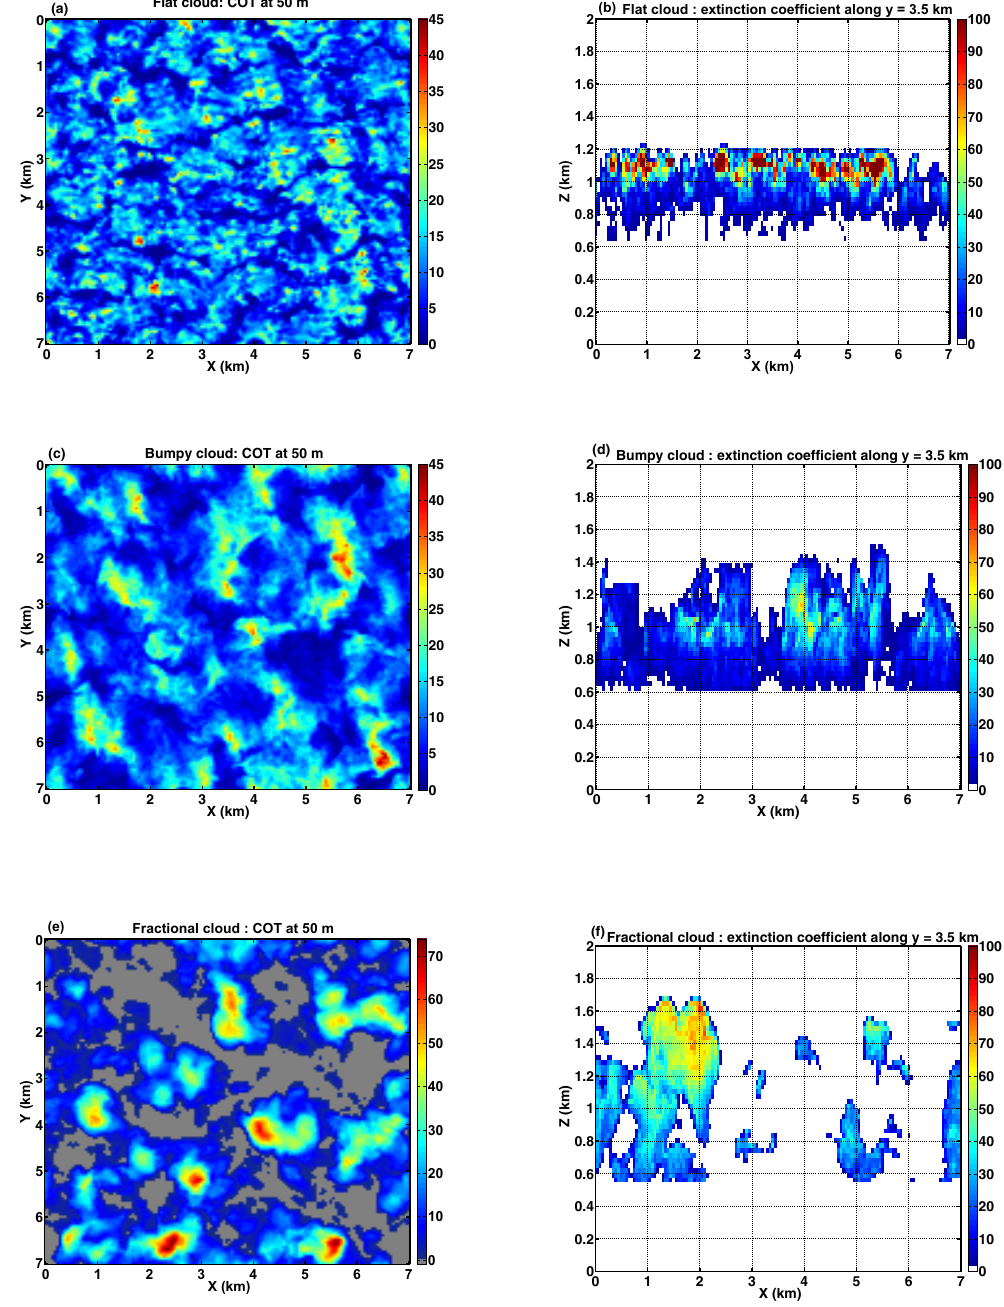
Figure 2. Cloud optical thickness (COT) of the three clouds used for the study (a) the flat cloud, (c) the bumpy cloud and (e) the fractional cloud. Extinction coefficient (km − 1 ) along the x − z axis for y = 3.5km for (b) the flat cloud, (d) the bumpy cloud (f) and the fractional